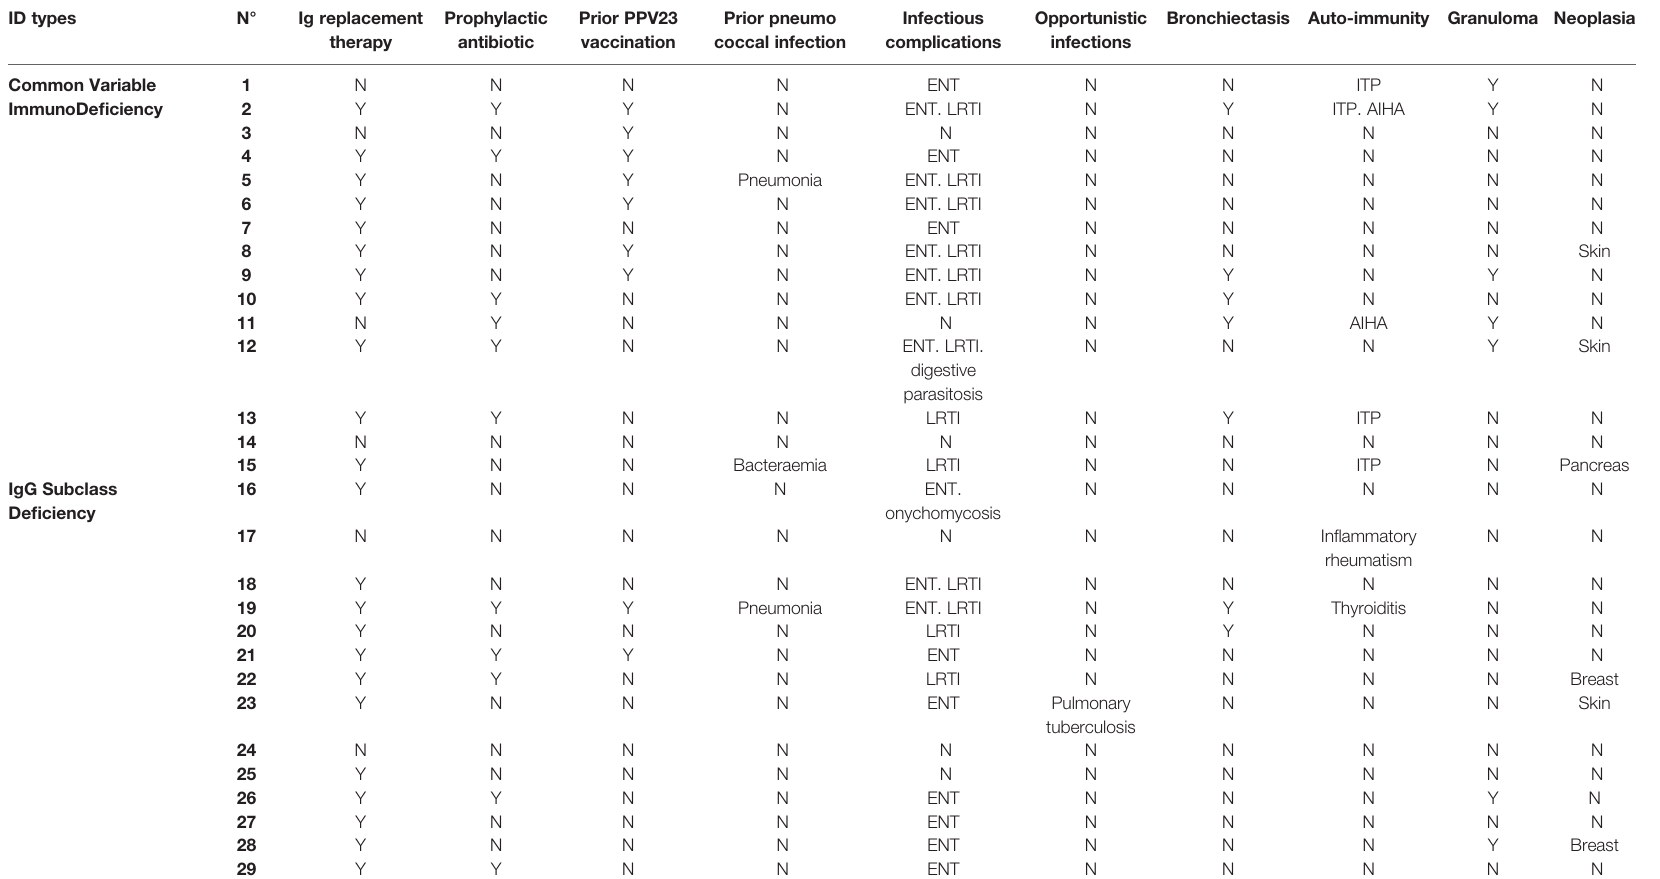
TABLE 2 | PID patients ’ clinical